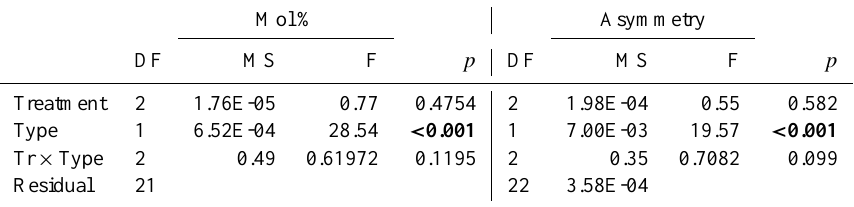
Table 1. Two factor analysis of variance (ANOVA) testing for difference in mol% MgCO 3 and Asymmetry indicating dolomite, between different CO 2 treatments (Factor Treatment) and experimental growth vs. pre-experimental growth (Factor Type). No significant difference (bold) related to CO 2 treatments, but significant difference between experimental and pre-experimental growth for both mol% MgCO 3 and dolomite asymmetry. Mol%